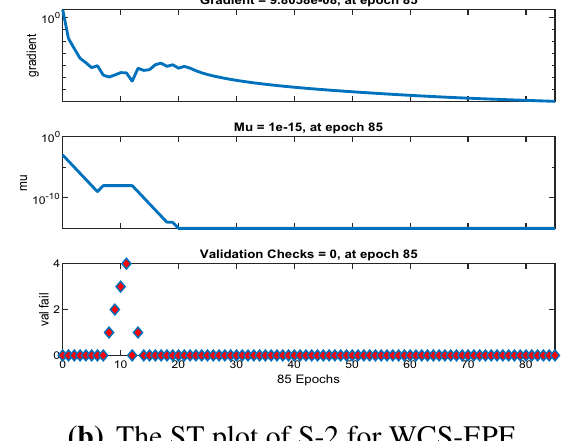
(b) The ST plot of S-2 for WCS-EPF.